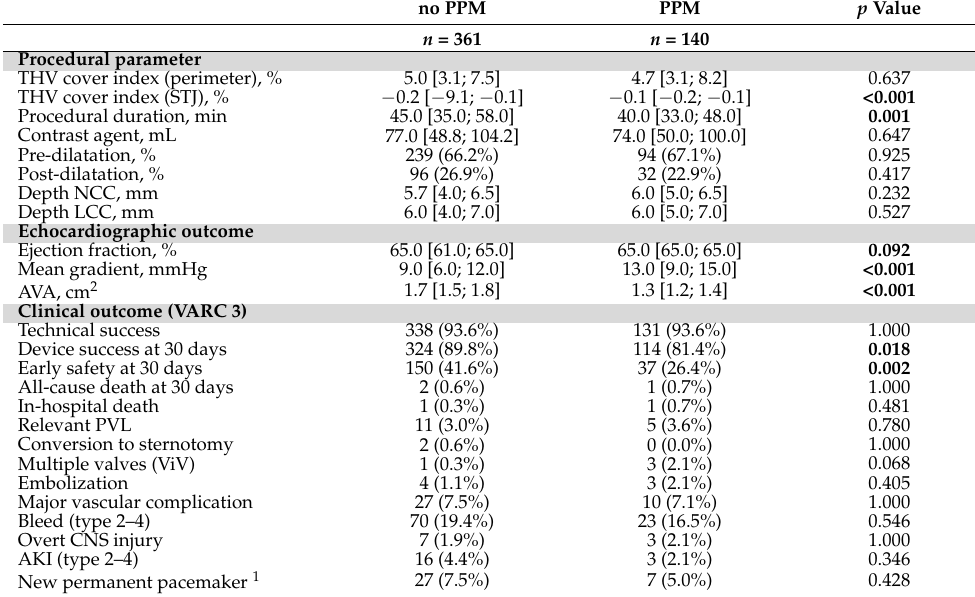
Table 4. Procedural data and outcome according to PPM.